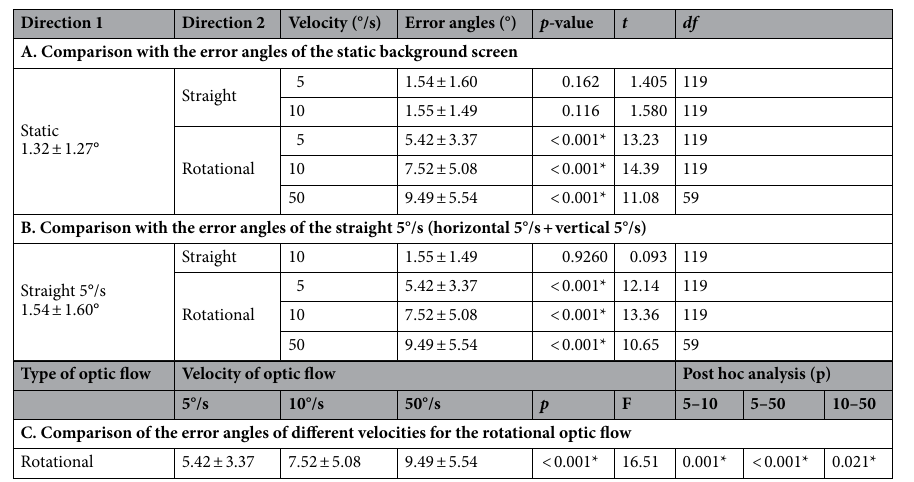
Table 1. Comparison of the error angles of each experimental condition of optic flows.